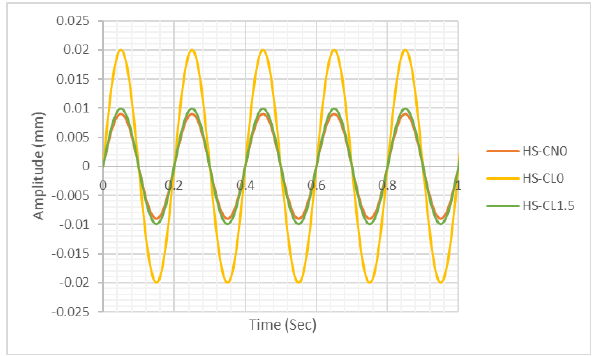
Figure 5: Vibration-time history under harmonic load with 5Hz